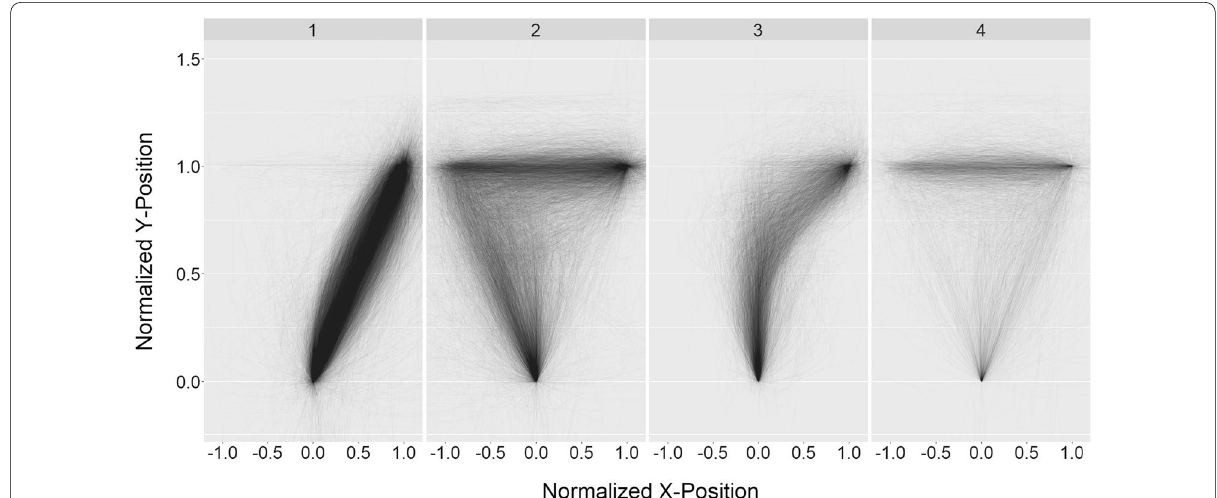
Fig. 6 Mouse trajectory clusters. Mouse trajectories were clustered into four groups: (1) Direct Trials where participants make little deviation from the direct path, (2) Late Switches where participants switch direction at the end of the trial, (3) Incremental Trials where processing happens incrementally, and (4) Switchbacks where participants switch directions twice after initially heading in the correct direction